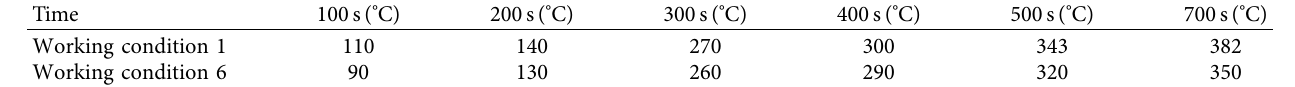
Table 8: Comparison of smoke layer temperatures under working conditions 1 and 6.